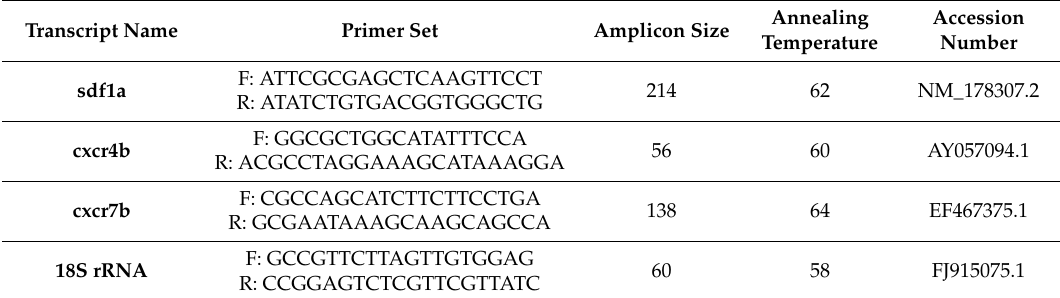
Table 2. List of primers designed for gene expression analysis. Sequences start from 5 (cid:48) to 3 (cid:48) . Amplicon size indicated as number of base pair (bp) and annealing temperature as grade Celsius ( ◦